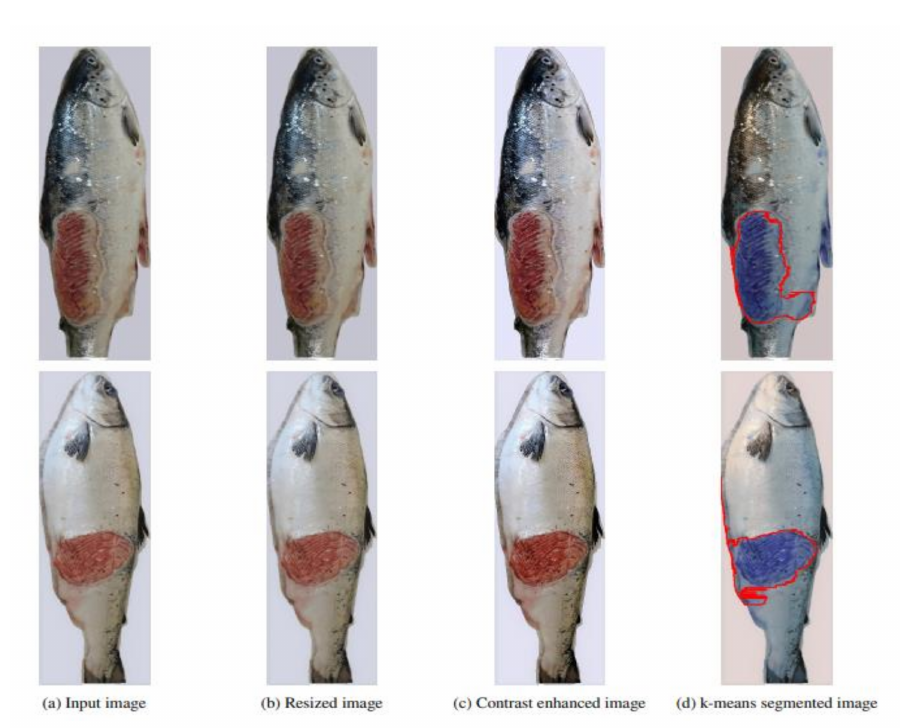
Figure 24. Various appearances of image processing.